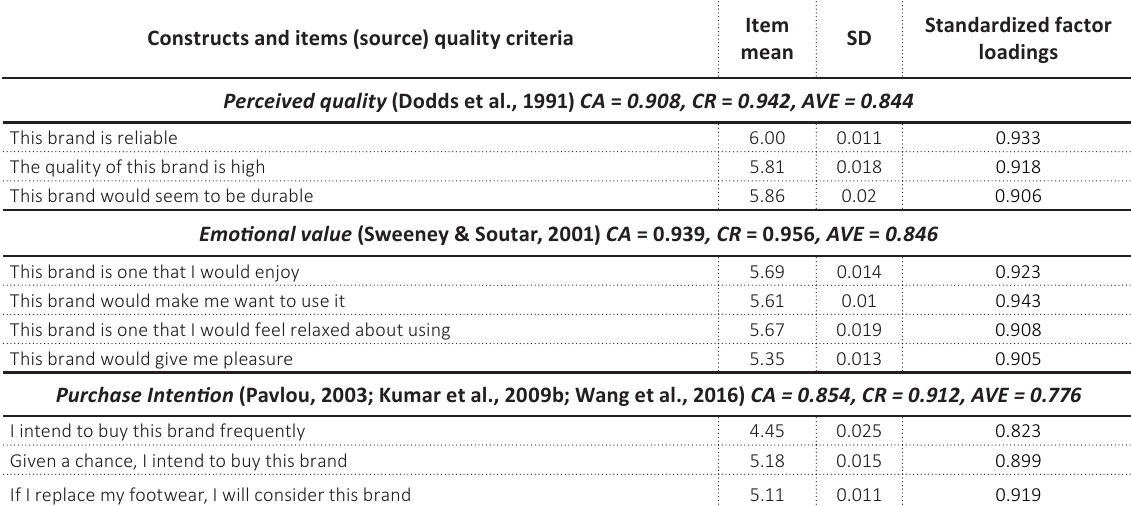
Table 1 (cont.). Evaluation of